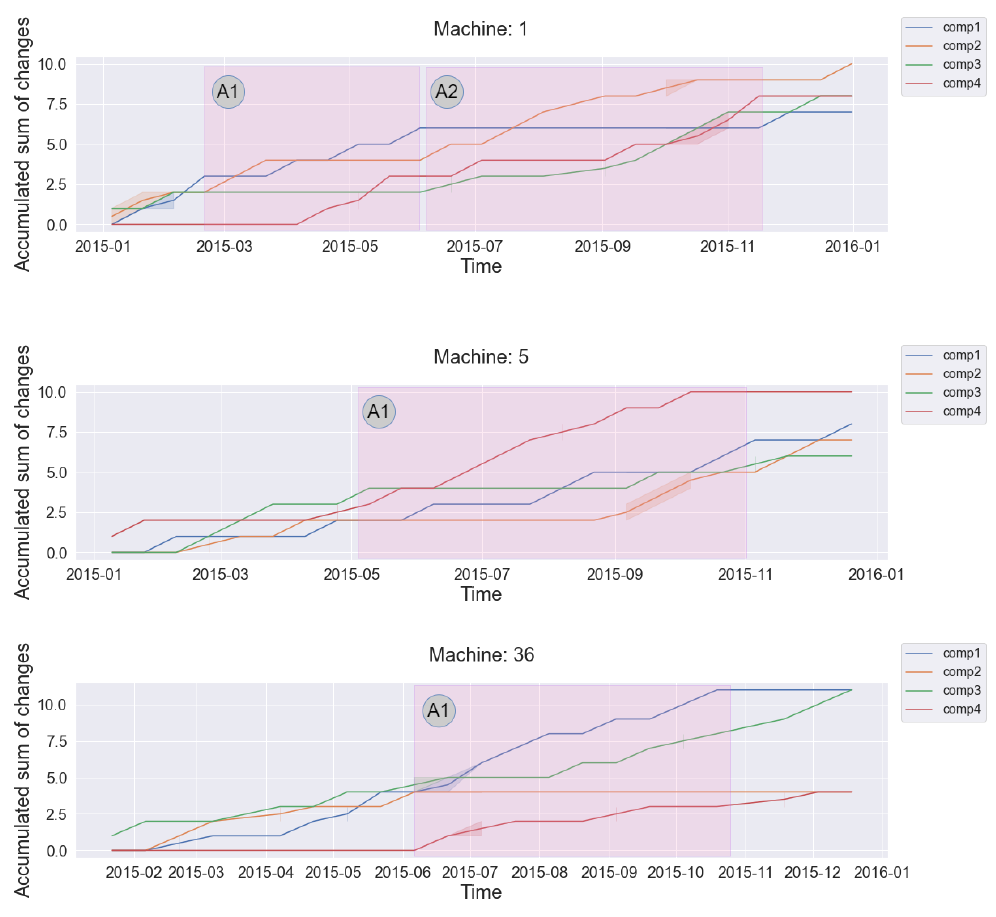
Figure 4. Visual inspection of interdependencies using multi-line charts. Each chart shows the interdependencies between components of a particular machine. In sections A1 and A2 interactions between components can be found. For example, machine 1-section A1 shows that component 1 strongly interacts with other